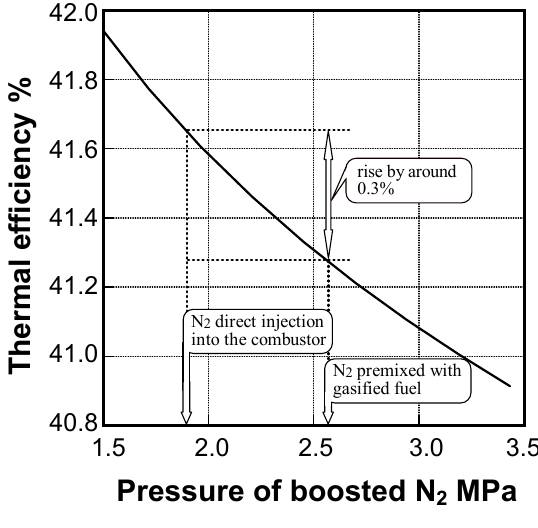
Figure 65. Influence of nitrogen boosted pressure on transmission-end thermal efficiency of the IGCC plant.